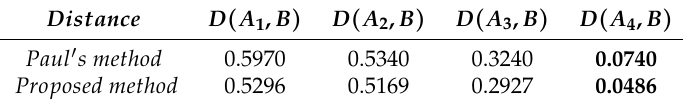
Table 4. The results generated by two methods in Example